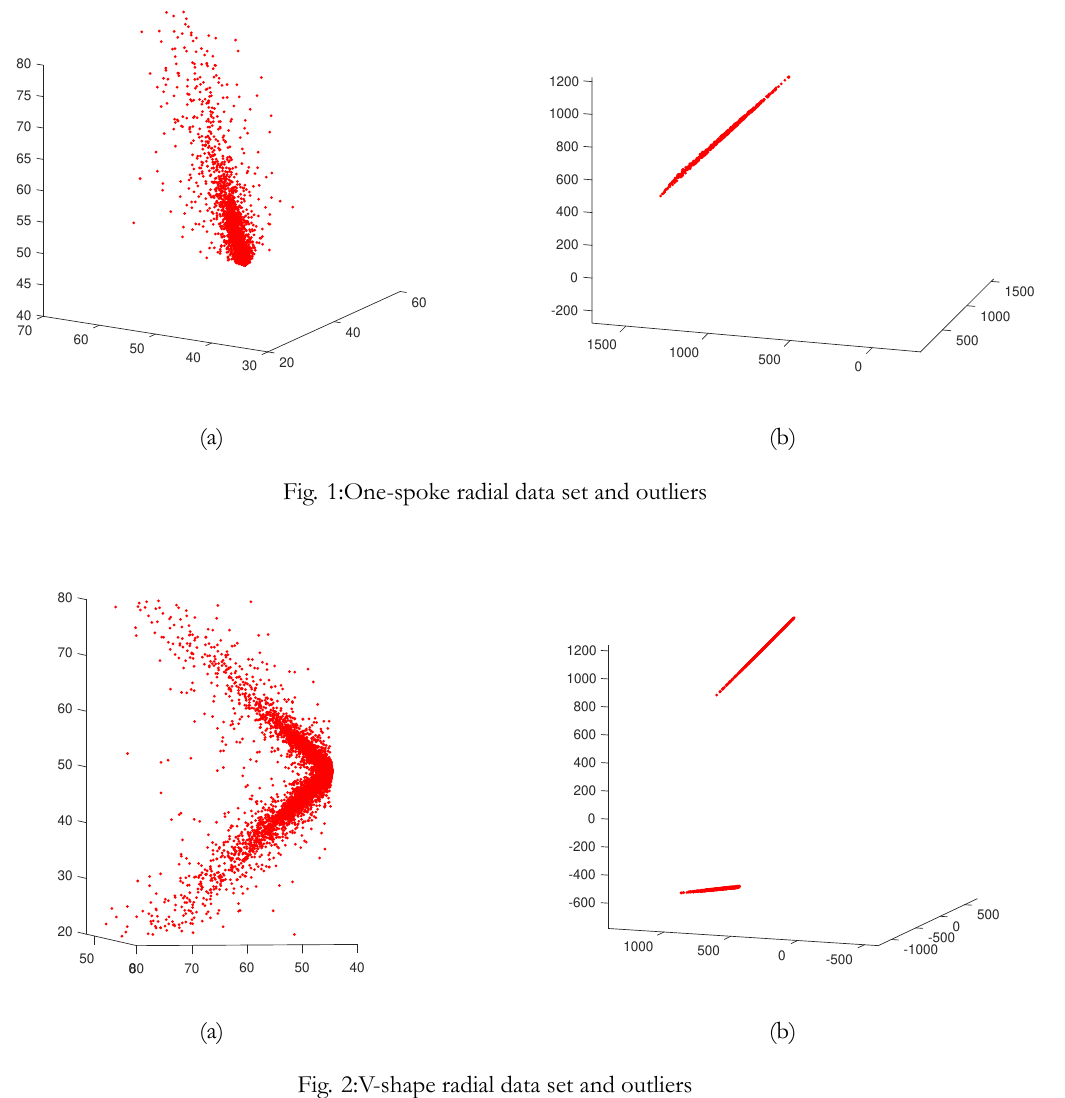
Fig. 2:V-shape radial data set and